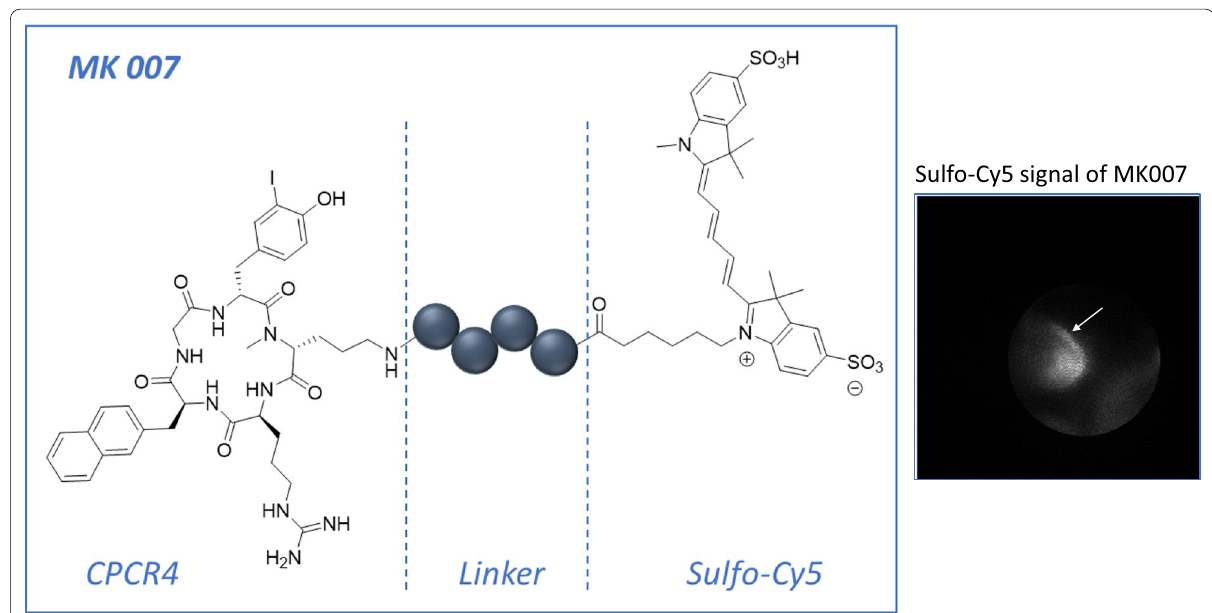
Fig. 1 Structure (left) and Sulfo‑Cy5 signal assessment (right) of the CXCR4‑targeted fluorescent ligand MK007. For the assessment of fluorescence signal before mouse endoscopy, Sulfo‑Cy5 MK007 1 mM was diluted in 0.9% NaCl to obtain a final concentration of 400 nmol/mL and